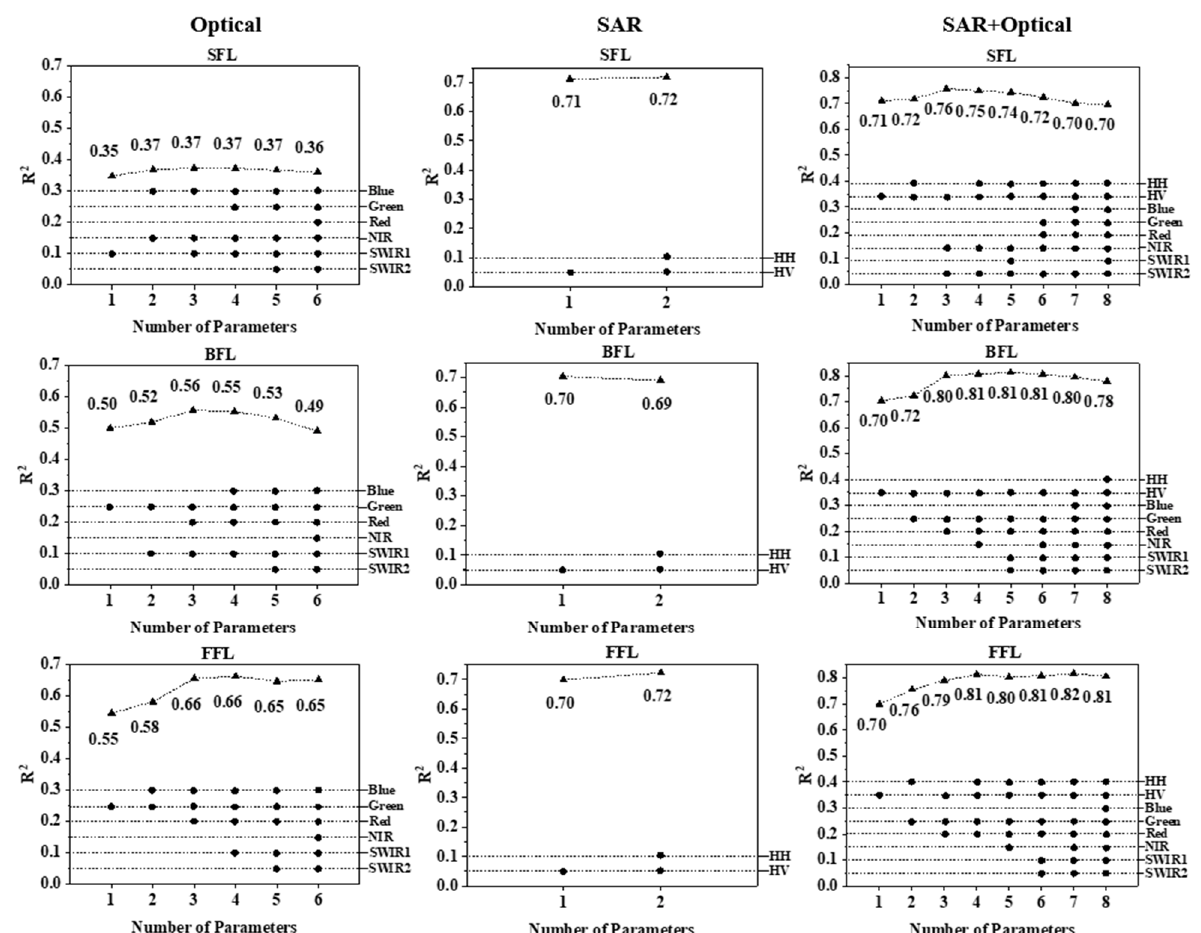
Figure 4. Parameter combination fitting results shows the best fitting results of multi-parameter models for above-ground forest fuel loads and the specific parameter combination information using optical data, SAR data, or both of them, respectively. The black solid triangles representing the R 2 of the optimal model combined with the number of parameters (1 to 8), and the black solid circles representing the parameters corresponding to the right vertical axis are included in the optimal model. Each parameter on the right vertical axis corresponds to a dotted line, reflecting the frequency of the corresponding parameter in the optimal model.